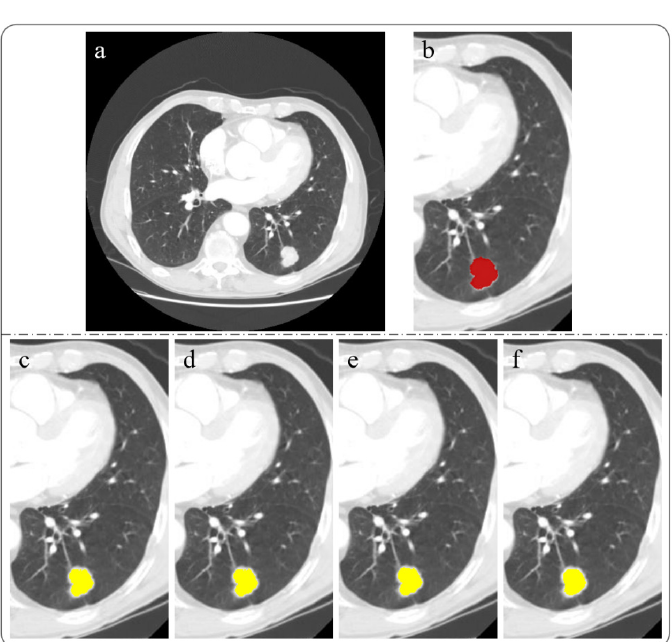
Figure 4. The segmentation result of our proposed method, and the red circle is the tumor boundary obtained after segmentation, ( a ) the target tissue contour obtained from the initial seed points of p1, p2, p3, p4, p5, p6, and p7, respectively, and their combination results, ( b ) final segmentation result. Figure 5 shows the different segmentation results obtained by our proposed method and the current popular FCM, K-means, SRM, and active contour algorithms.